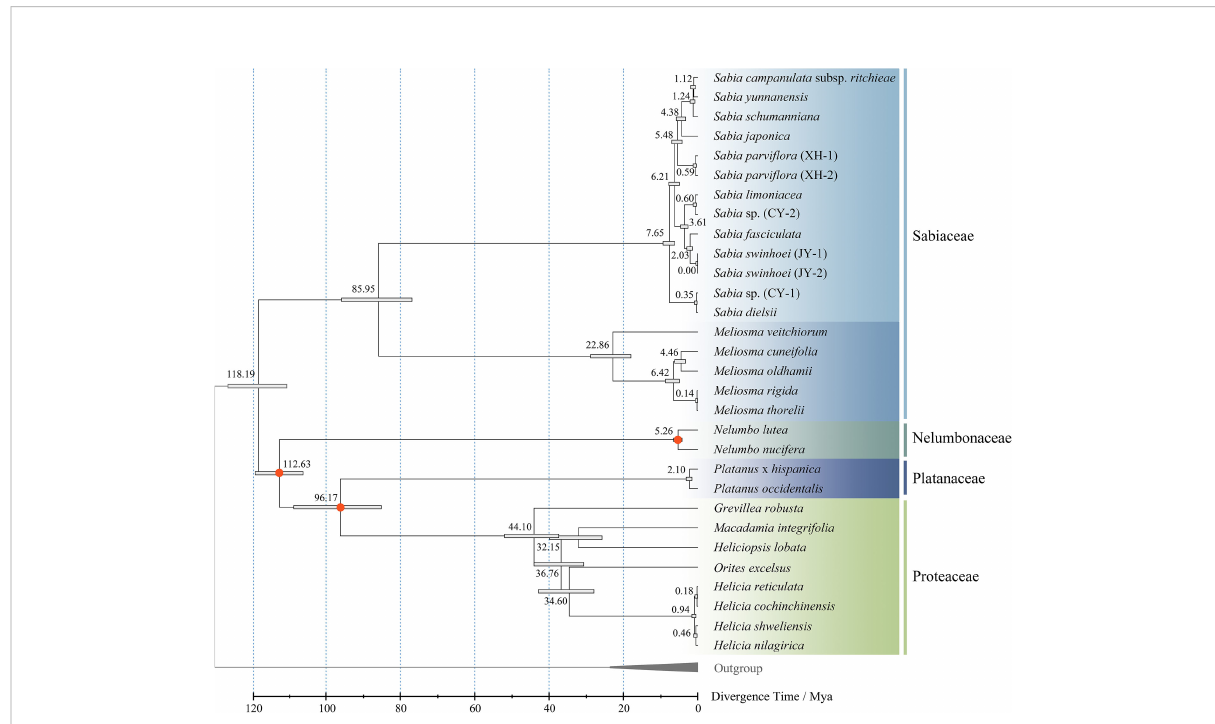
FIGURE 9 Divergence time estimation of genus Sabia . The numbers of the nodes represent the divergence time. Bars at the nodes represent 95% con fi dence intervals. Calibration points are marked with red.